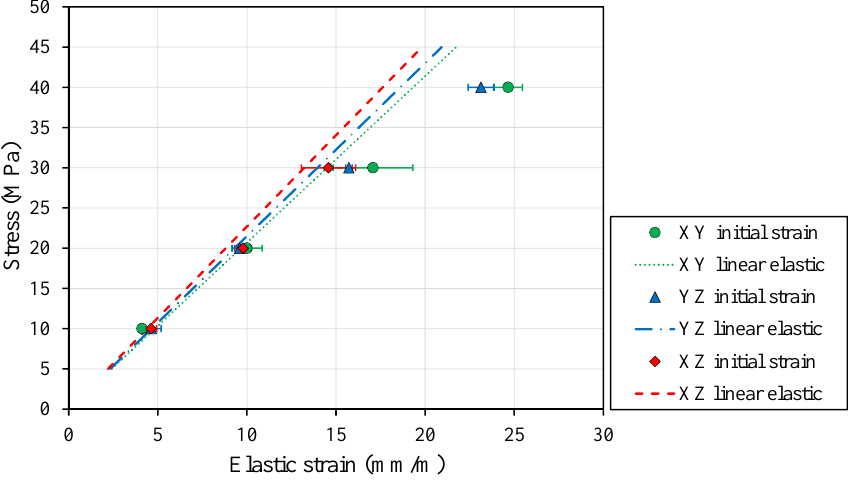
Figure 2. Predicted linear elastic behaviour (dashed lines) based on previous publications (YZ, XZ) [35] and tensile tests (XY). The initial elastic and plastic strain in the creep and relaxation tests (markers) were underestimated by the linear model.